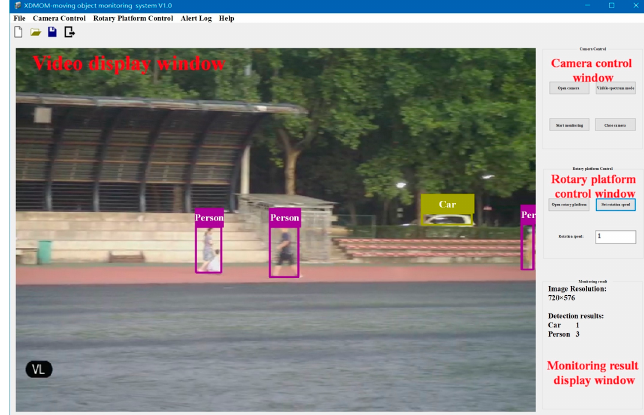
Figure 3. Software of the novel system in visible-spectrum mode.